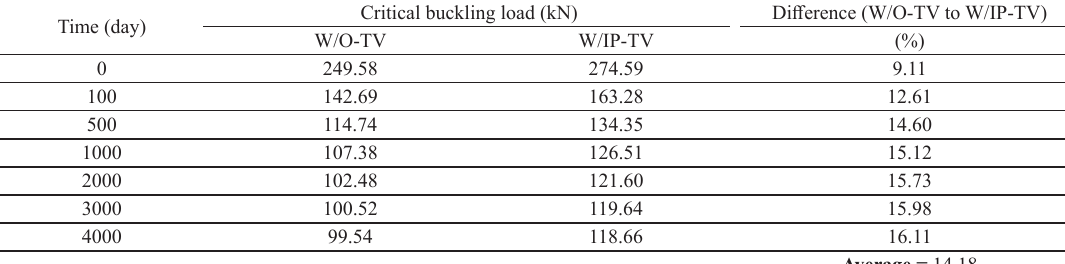
Table 1. Obtained results from ∆ T = 0ºC and ∆ T = +15ºC. Time (day)